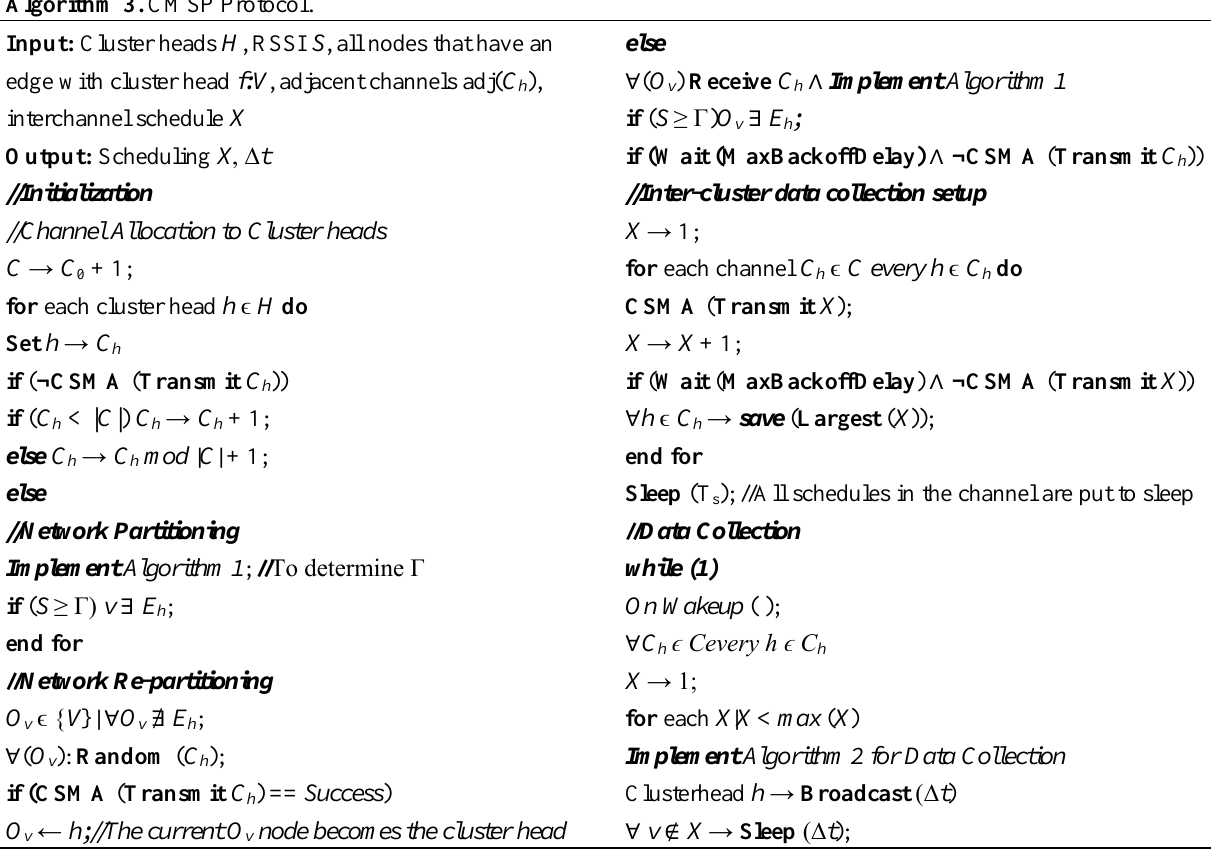
Table A1. Clustered multi-channel scheduling protocol (CMSP) Protocol. Algorithm 3. CMSP